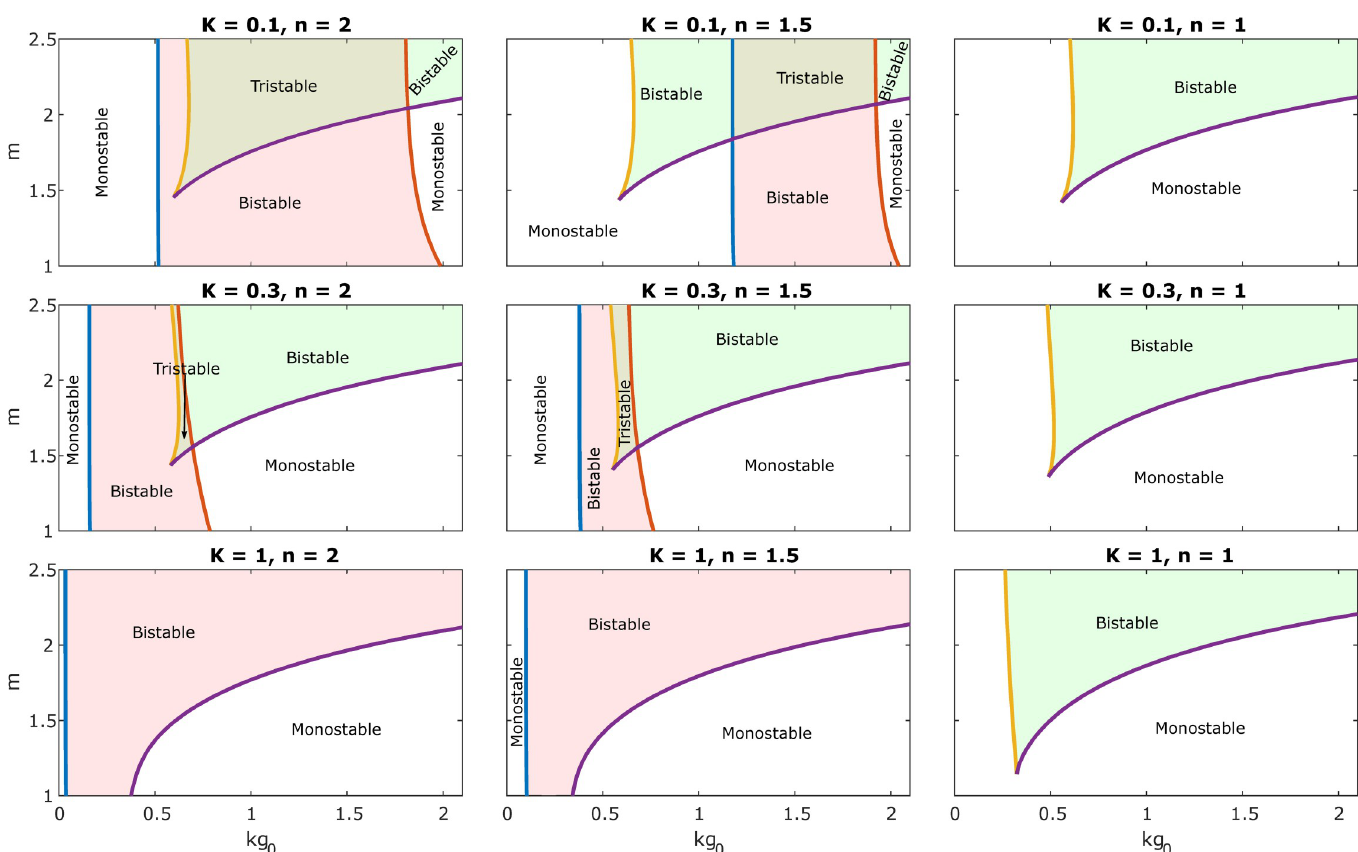
Fig 3. Tristability emerges from synergism between the self-activation circuit feedback and growth feedback. Two-parameter bifurcation diagram with respect m and kg 0 , for different values of hills coefficient n representing the sensitivity of the circuit feedback and K representing the threshold of the self-activation. Solid blue, orange, yellow, and purple lines represent saddle-node SN1~SN4, respectively.